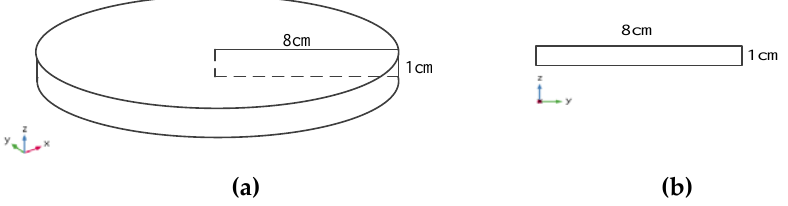
Figure 12. Geometry of the berry puree: ( a ) 3D structure; ( b ) Simplified two-dimensional